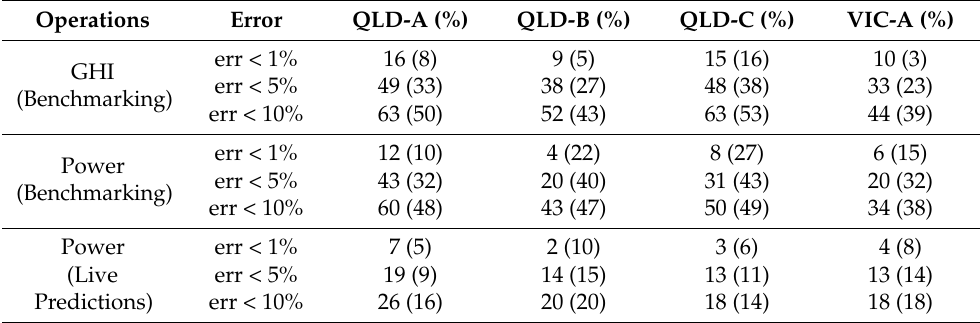
Table 9. SIFM skill compared to simple persistence forecasts in the benchmarking and live period.